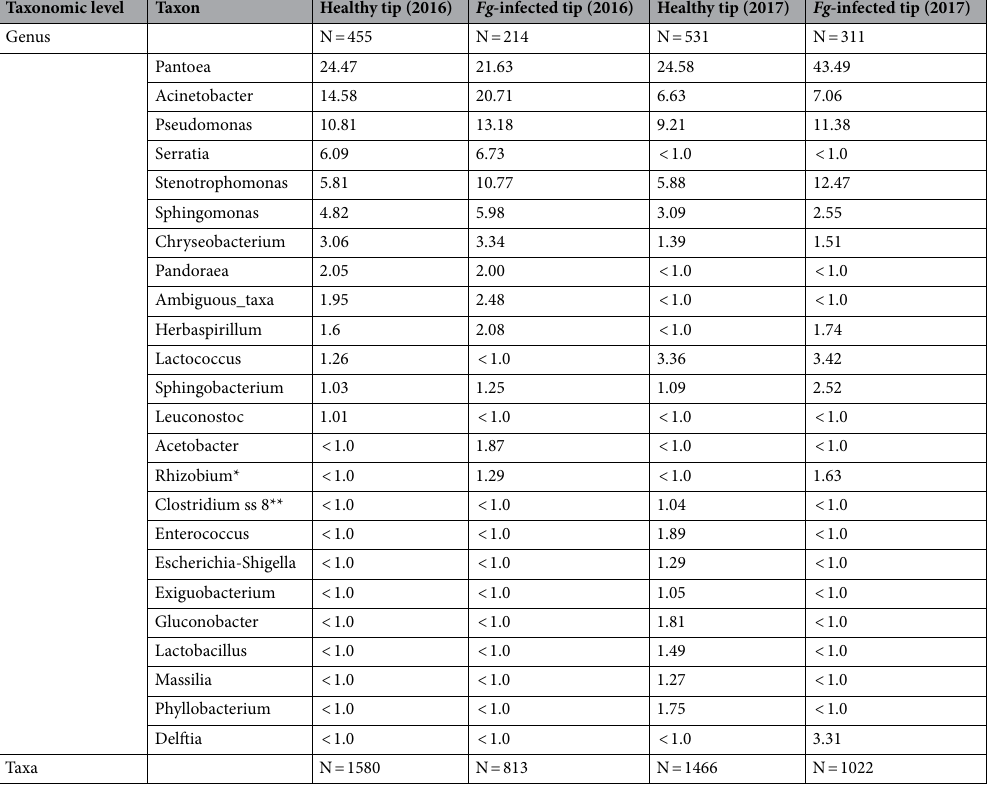
Table 1. Summary of TSM taxa at genus level inhabiting silk tip tissues with mean relative abundance of > 1% in at least one of the 4 sample groups. *Allorhizobium-Neorhizobium-Pararhizobium-Rhizobium. **Clostridium sensu stricto